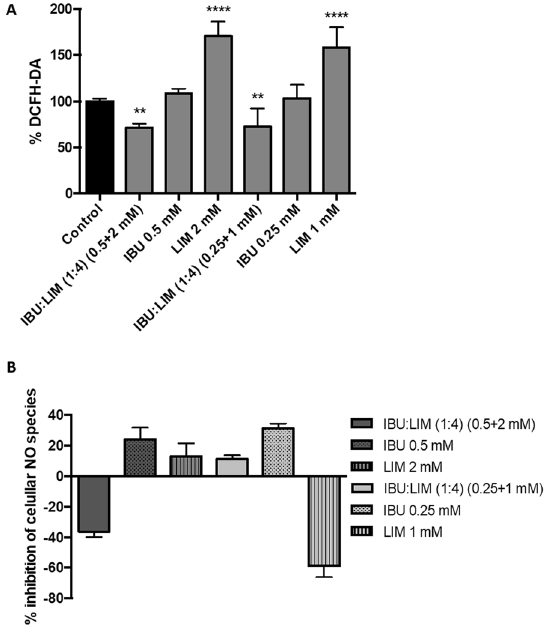
Figure 6. Effect of IBU:LIM (1:4), IBU and LIM on ROS accumulation ( A ) and NO production ( B ) using HT29 cell model with 24 hours treatment. Results were expressed relatively to the control as mean ± SD of three independent experiments performed in triplicate. Statistical significant differences were calculated according to one-way ANOVA for multiple comparisons by Dunnett’s method ( ** = P ≤ 0.01, **** = P ≤ 0.0001).